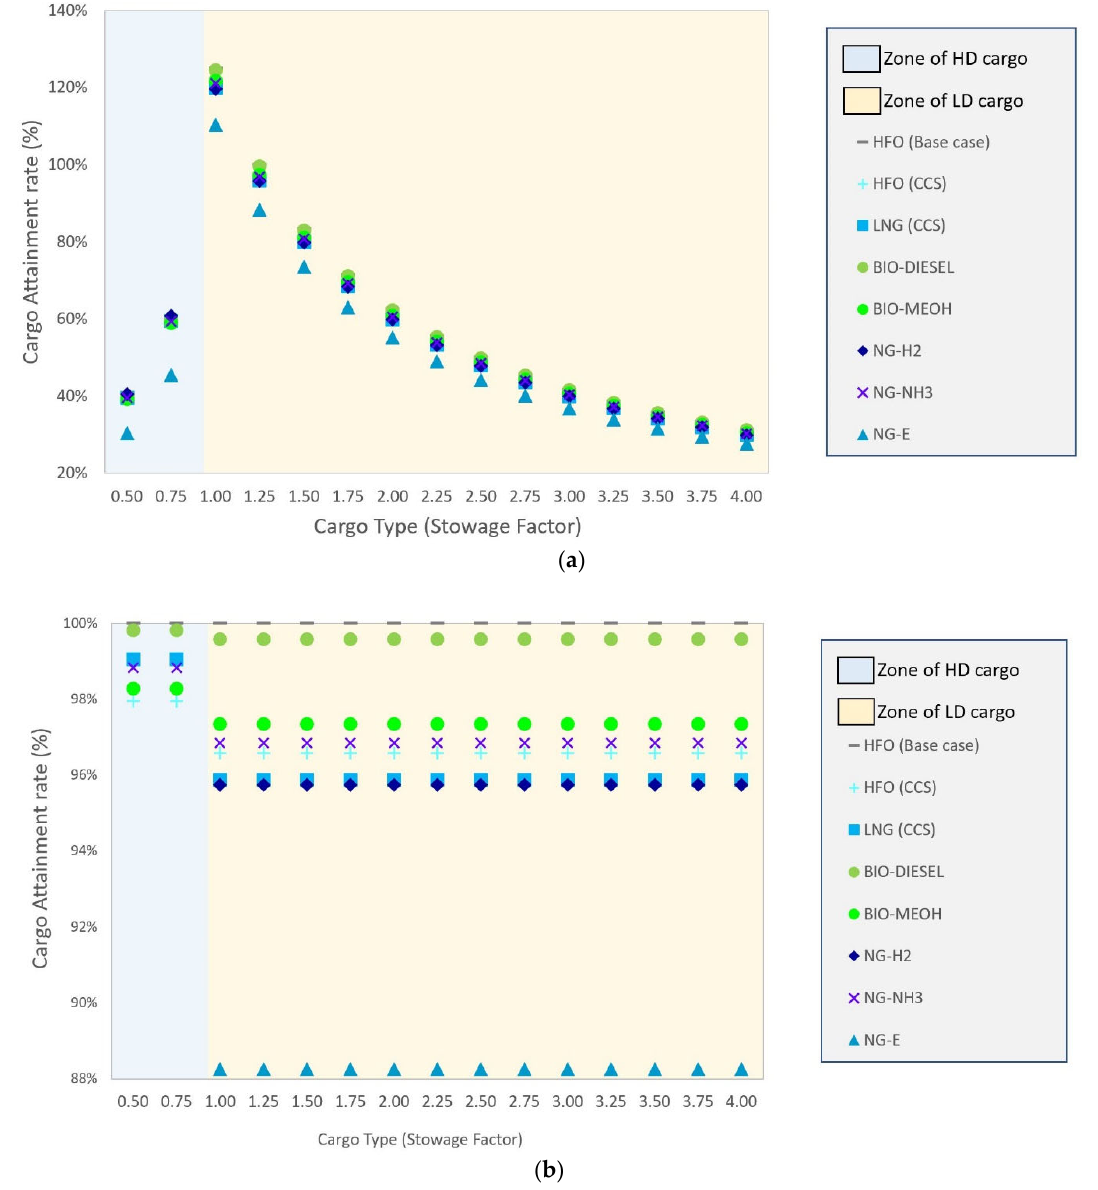
Figure 6. Cargo attainment rate (mass) as a function of cargo stowage factor (m 3 /ton) for various fuels, for containership travels a voyage length of 10,000 nm; ( a ) when the reference ship is carrying cargo with SF 1.25 m 3 /ton, and ( b ) when the reference ship is carrying the same cargo as the ship being considered.